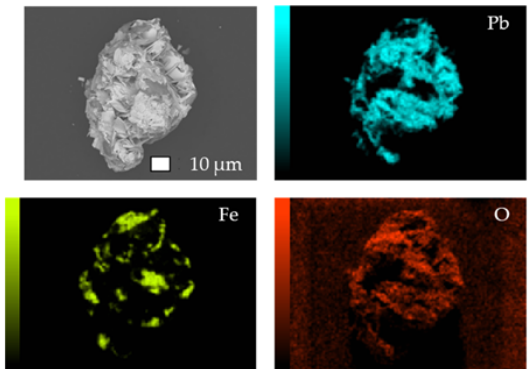
Figure 6. SEM photomicrograph of the residue of the cementation experiment using 1 g/10 mL of